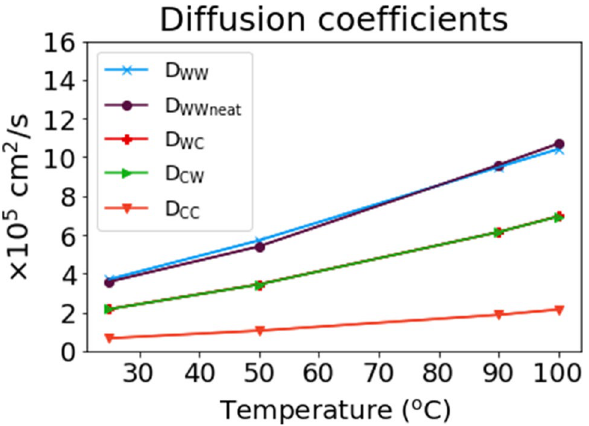
Figure 8. Diffusion coefficients in bulk water (D WW ) and for water molecules sorbed to the cellulose bundle (D CC ). The diffusion in the bulk phase was validated against the diffusion of water calculated by Gromacs (Gromacs_MSD, ref. 8 in SI, Eq.1 in SI-6) in a system without a cellulose bundle (D WWneat , described in